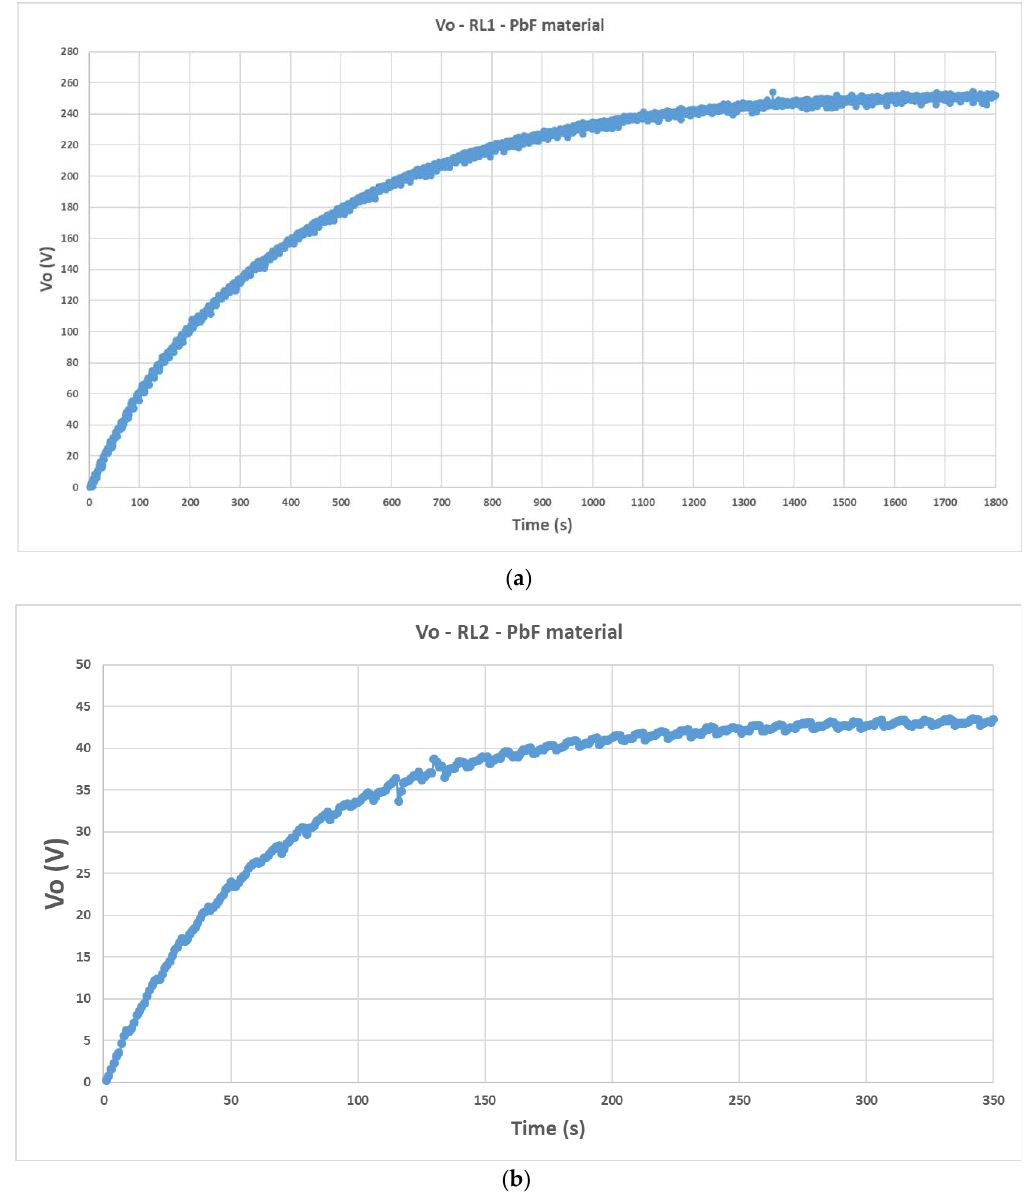
Figure 14. Transient response and steady state of the accumulated voltage in the capacitor ( C _load = 1 µF) of the harvesting circuit when PIC700 lead-free piezoelectric material is utilized in the Test Bench: ( a ) Output voltage recorded by VI when using a set of resistors of equivalent R _load1 = 300 MΩ; ( b ) output voltage when R _load2 = 50 MΩ .